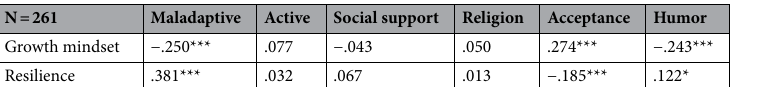
Table 3. Pearson correlations between mindset and resilience, with 6 coping subscales based on PCA. Note that the resilience variable is reversed, meaning that higher resilience is related to less maladaptive, less humor, and more acceptance coping styles. * p < .05, ** < .01, *** < .001.